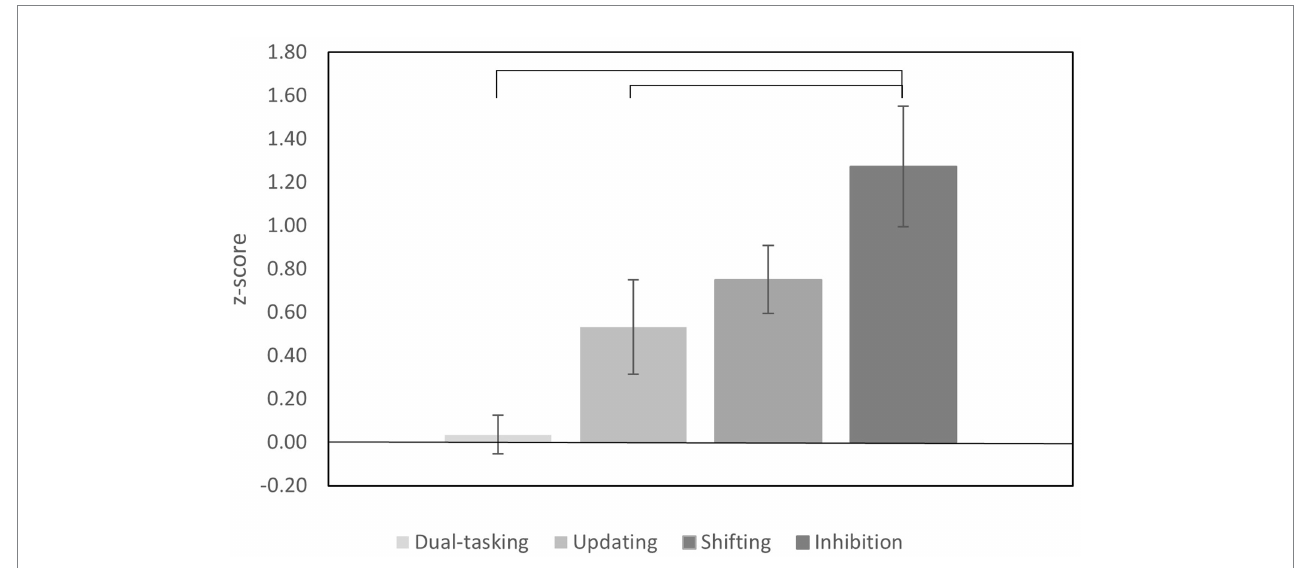
FIGURE 1 Decline in executive function abilities amongst the older adults. The bars represent the z-score data from the four executive function tasks presented in Table 4. Error bars represent the standard error of the mean. The bracket lines present the significant